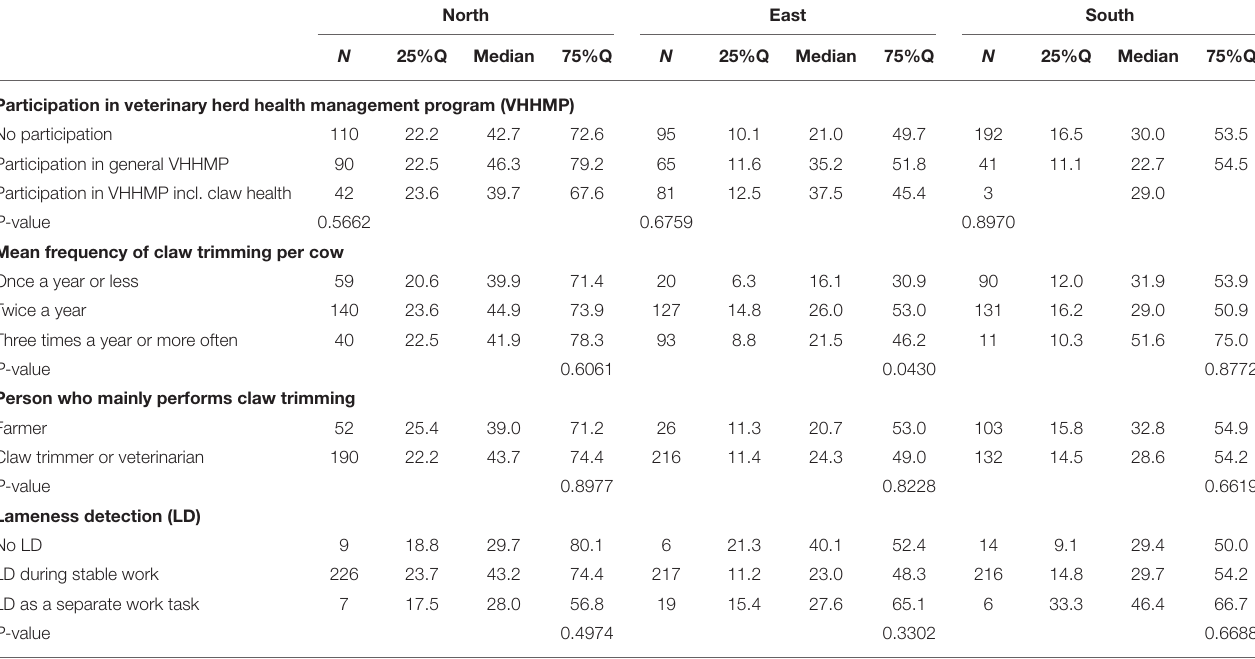
TABLE 5 | Association (Kruskal-Wallis-test) and descriptive analyses of Farmer’ Detection Index depending on claw health management. North East South